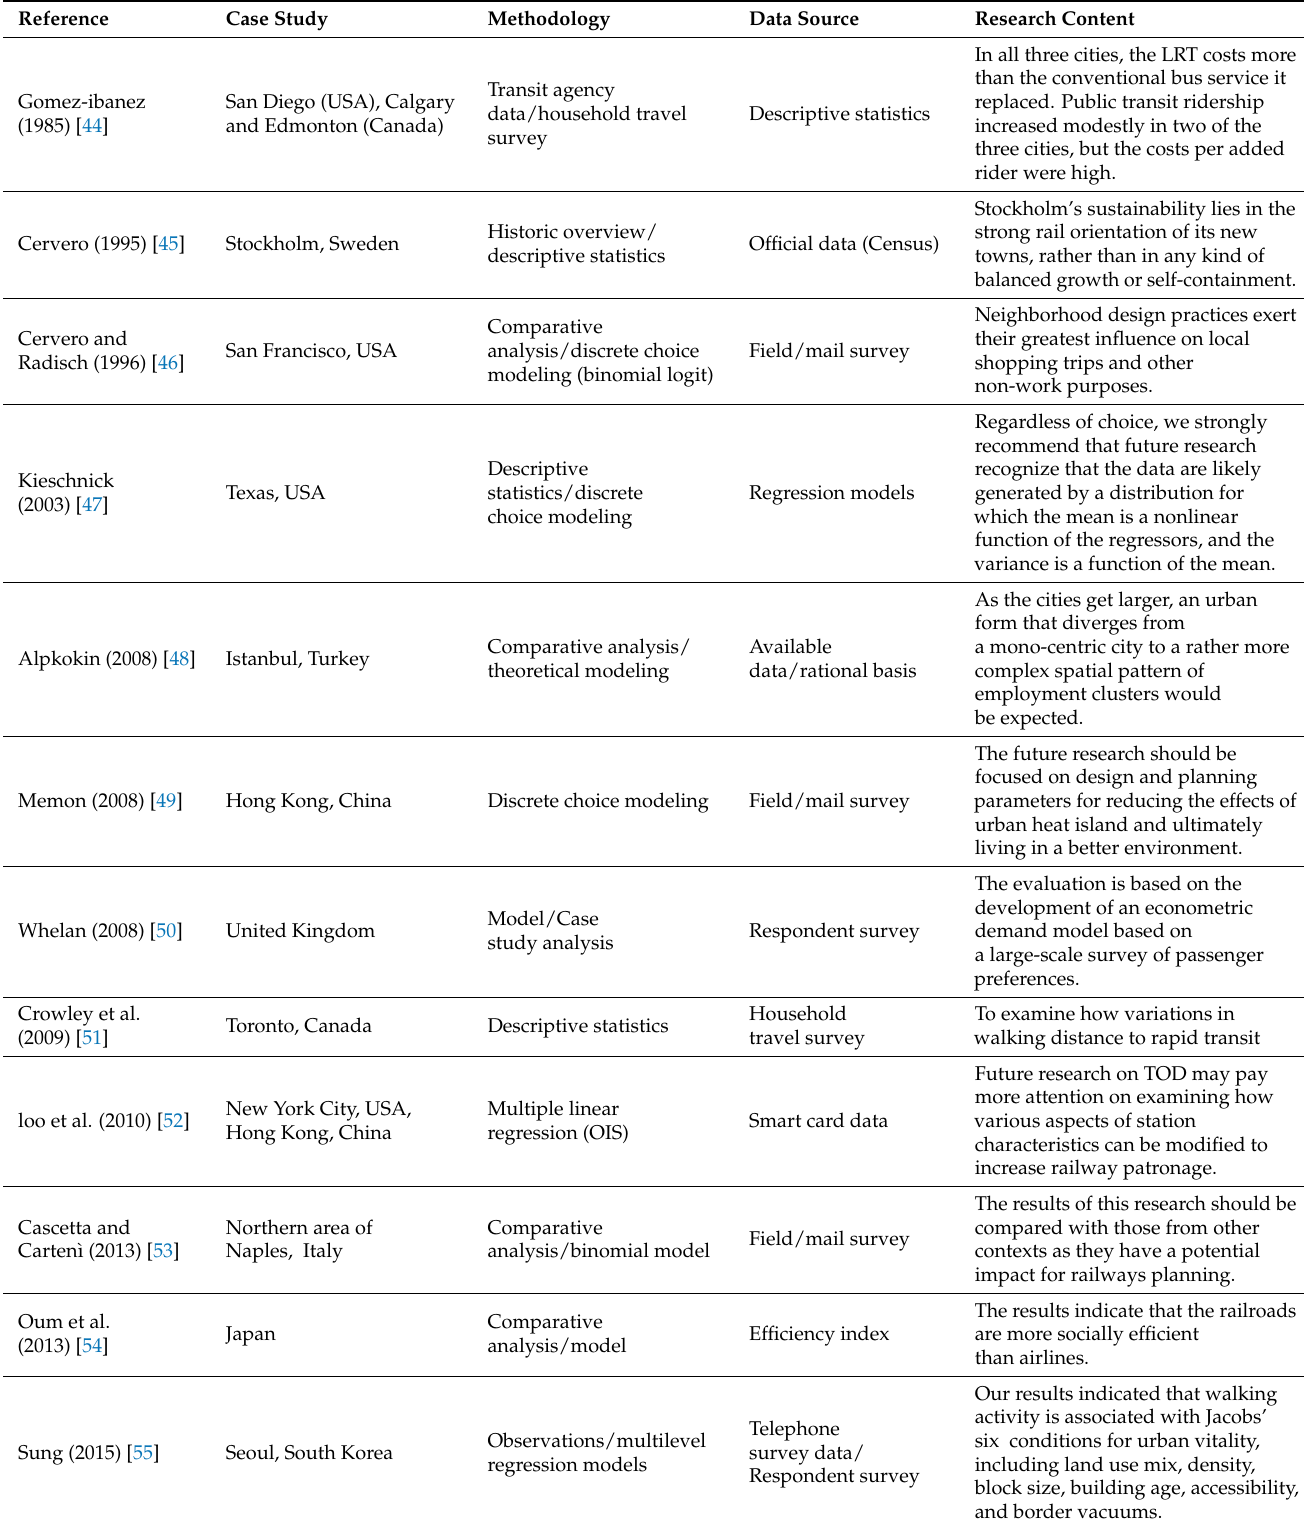
Table 1. World literature on rail transit development, urban growth, and